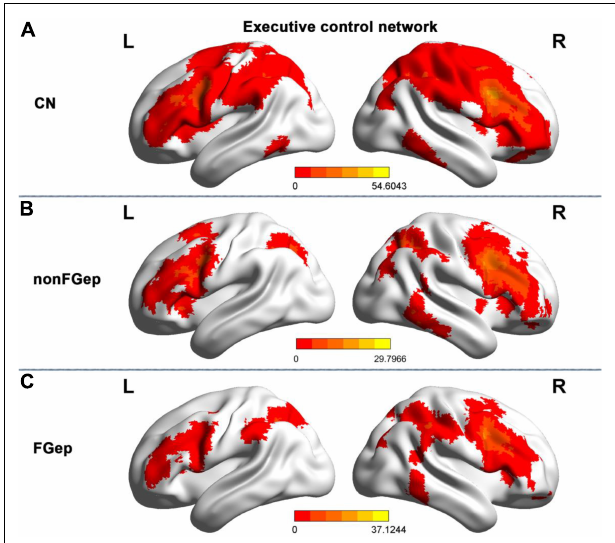
FIGURE 1 | Resting-state functional connectivity patterns of the executive control network within group maps in CN (A) , non-FGep (B) , and FGep (C) subjects. CN, healthy controls; non-FGep, frontal glioma without epilepsy; FGep, frontal glioma with epilepsy; PreCG, Precentral gyrus; L, left hemisphere; R, right